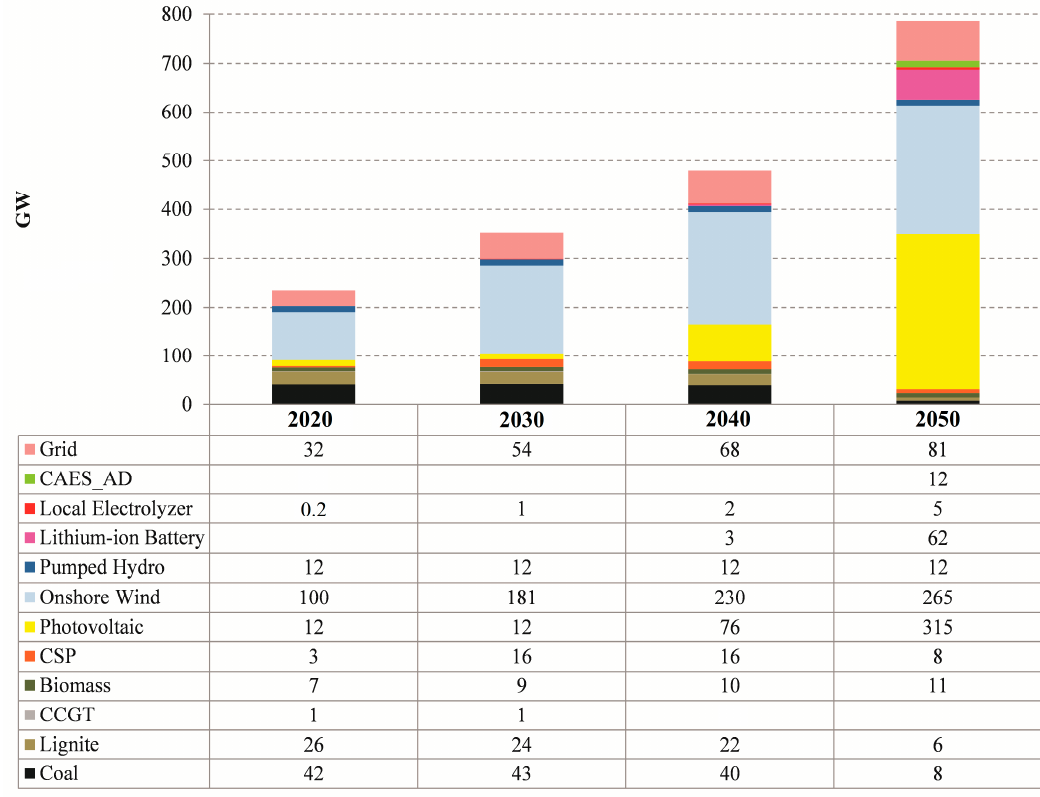
Figure 7. Total installed capacity by technology in the BTH metropolitan region. Energies 2020 , 13 , x FOR PEER REVIEW